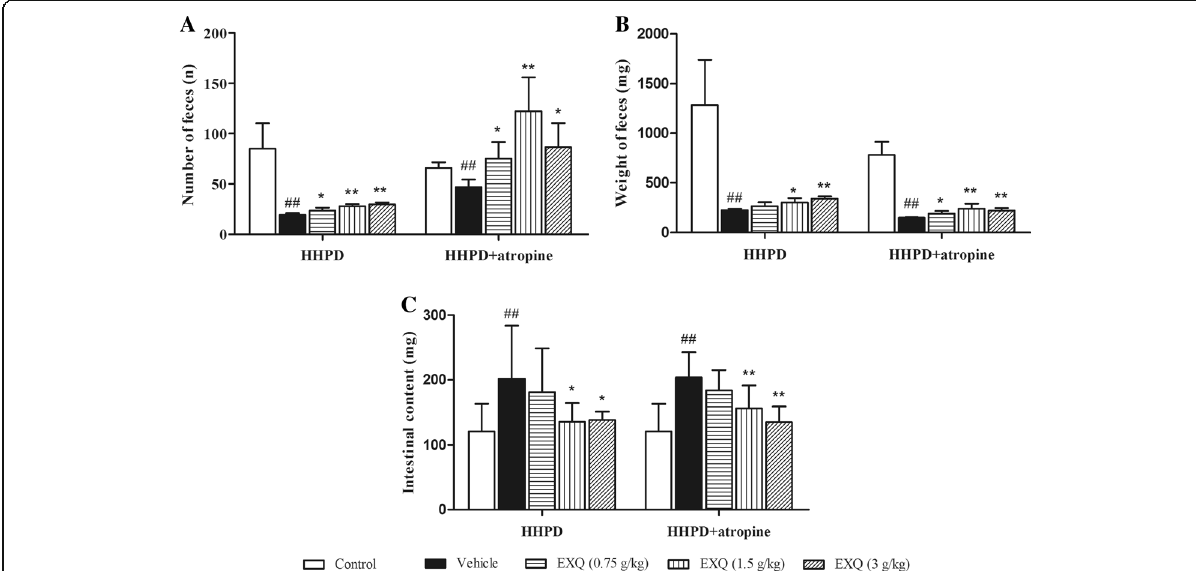
Fig. 1 Effect of EXQ on intestinal mobility in two models of experimental constipated mice. Mice were orally given EXQ at the doses of 0.75, 1.5 and 3 g/kg, respectively. a number of feces; b weight of feces; c weight of intestinal content. Data are presented as the mean ± SD ( n = 8). # P < 0.05, ## P < 0.01 compared to the normal control group; * P < 0.05, ** P < 0.01 compared to the vehicle group